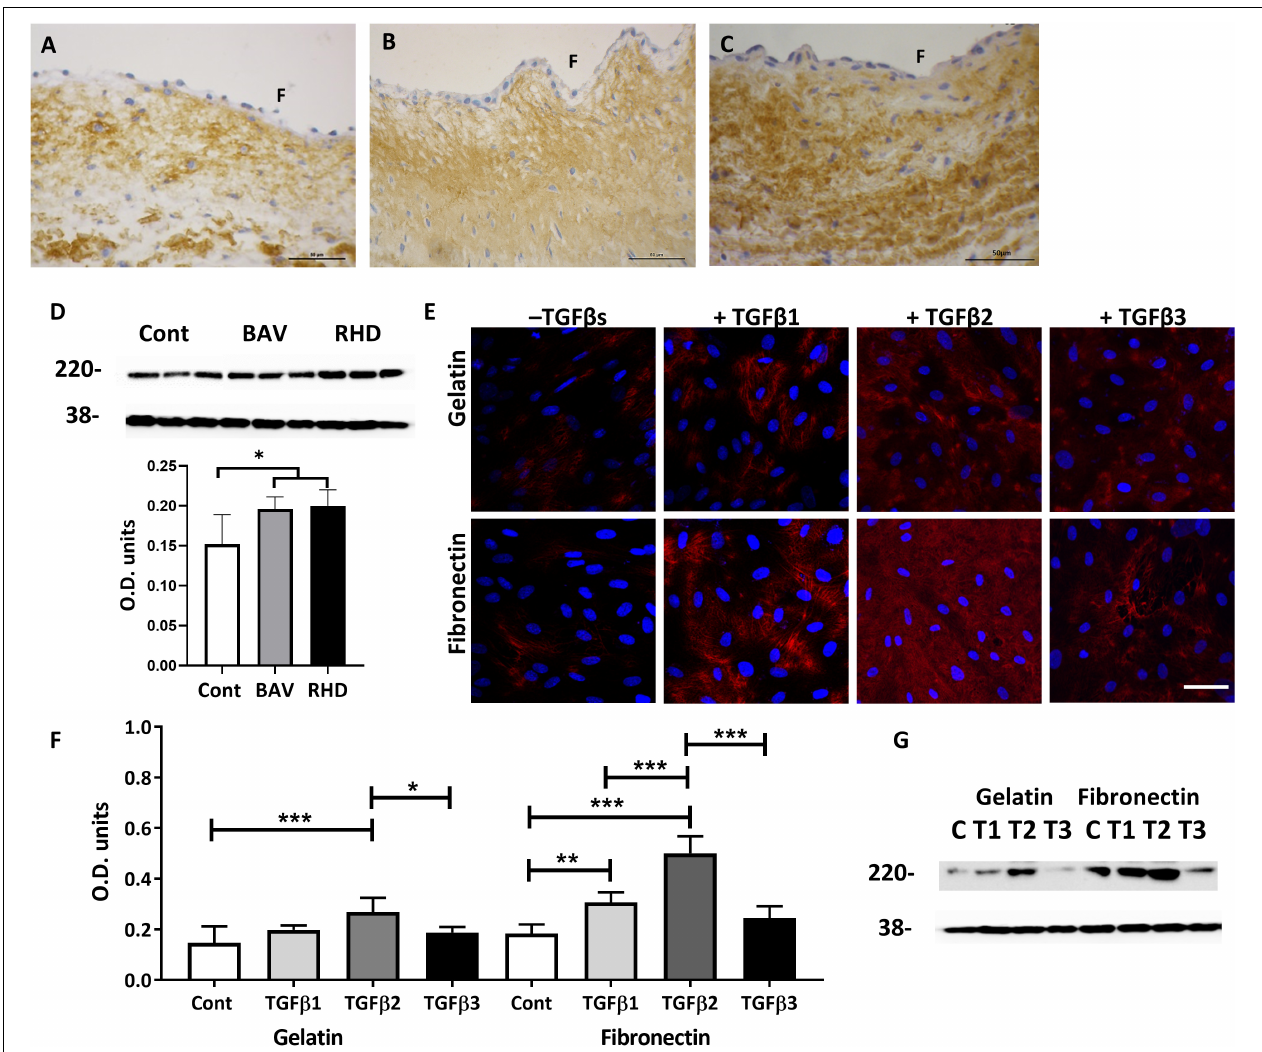
FIGURE 6 | The expression of fibronectin on a normal (A) BAV, (B) RHV, (C) cusp, and quantitative levels (D) . The expression of fibronectin by VECs plated on gelatin (top panel) and on fibronectin (bottom panel) and treated with TGFs (E) . Graph showing the level of expression of fibronectin by VECs when plated on gelatin or fibronectin and treated with TGFs (F) and the corresponding Western blot showing levels of fibronectin at 220 kD and the housekeeping protein GAPDH at 38 kD (G) . Panel (F) represents the fibrosal side. Scale bar in panel (A–C) is 50 µ m, in panel (D) is 100 µ m. * p ,0.05, ** p < 0.01, *** p < 0.001.